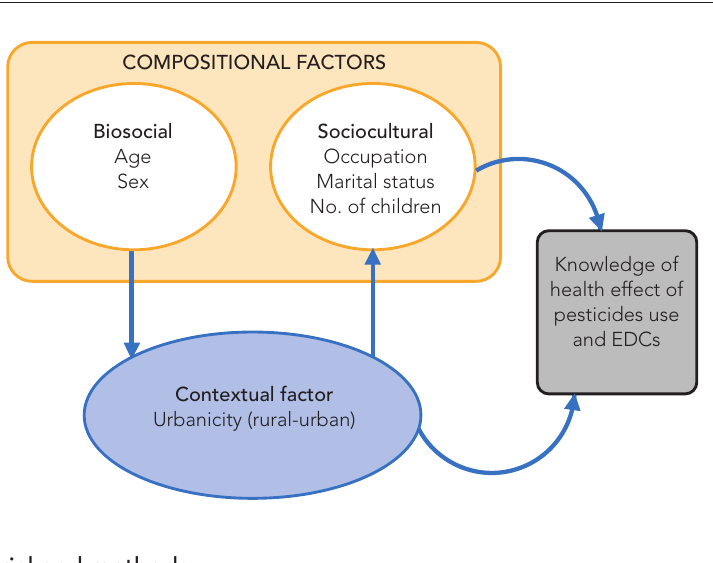
Figure 1. Conceptualisation of the relationship between Knowledge of health effect of EDCs and compositional and contextual